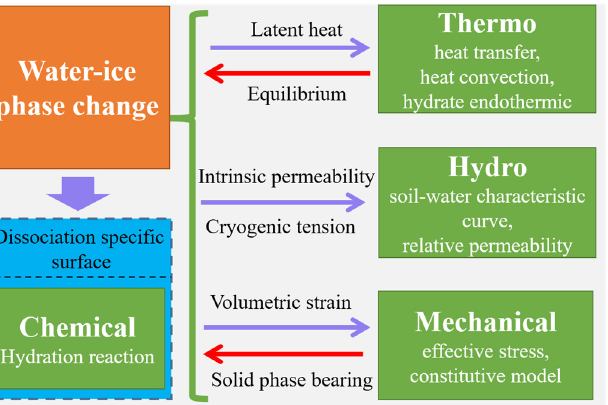
Figure 1. The effect of thermo-hydro-mechanical-chemical multiphysics is considered from the per- spective of ice. perspective of